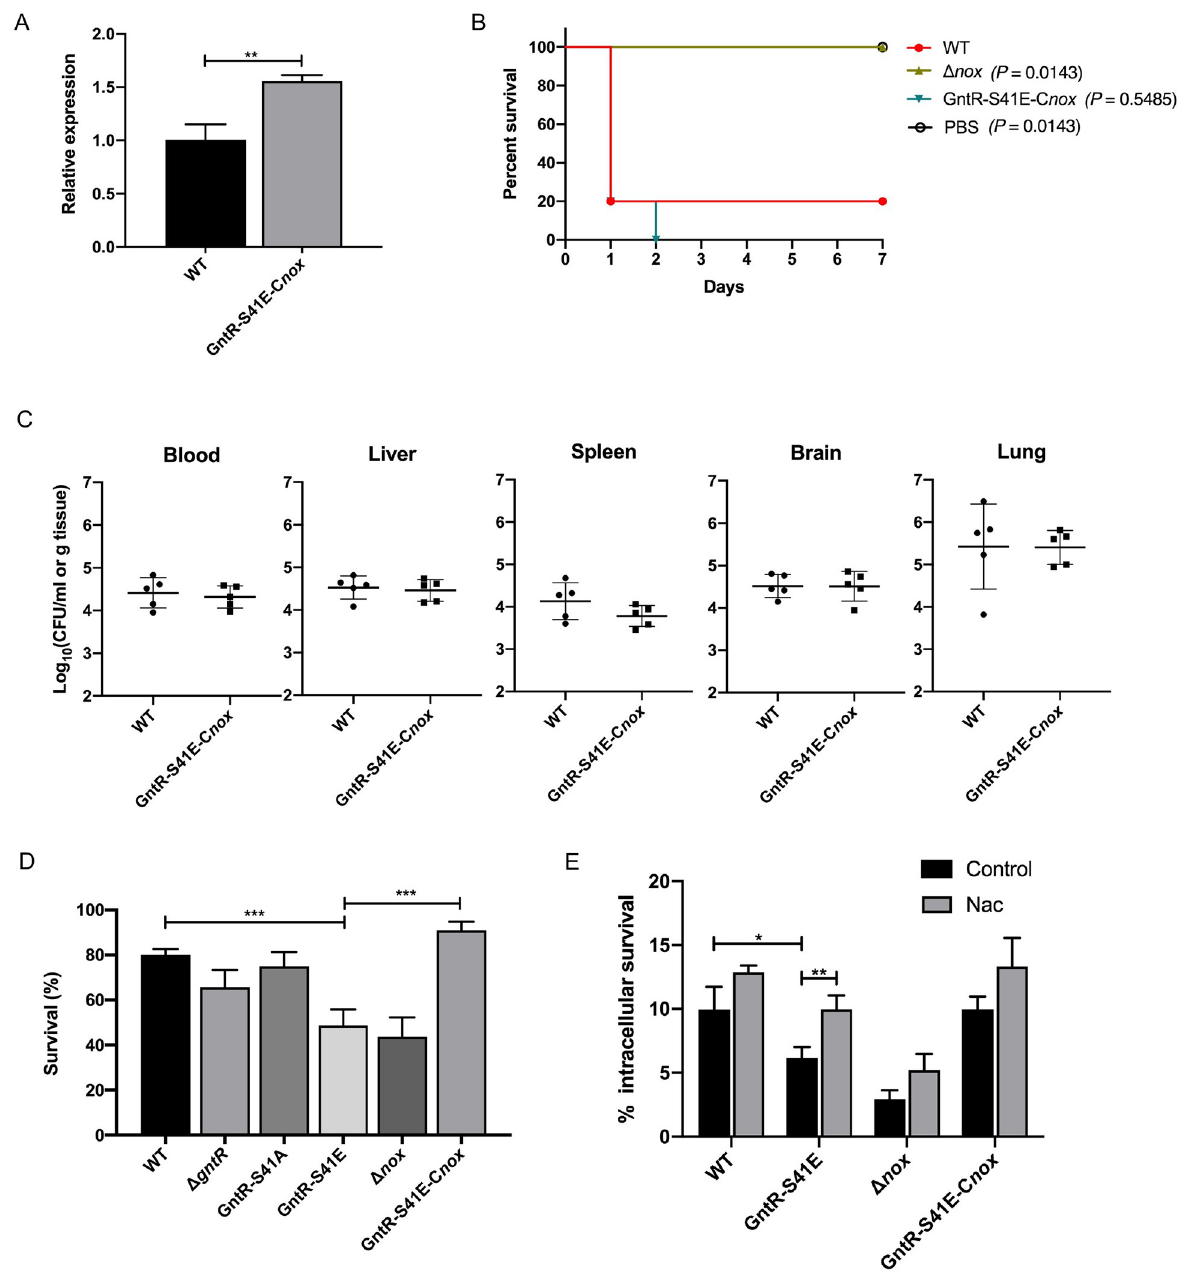
Fig 4. Attenuated virulence and antioxidative capacity of the phosphorylation of GntR are associated with the transcriptional repression of nox . (A) The gene of nox transcript levels in WT SS2 and GntR-S41E-C nox were detected by RT-qPCR. (B) BALB/c mice were challenged by intraperitoneal injection with WT SS2 and GntR-S41E-C nox at a dose of 5 × 10 8 CFUs/mice (n = 5 mice/group), and the survival time was monitored. (C) Bacterial loads in the blood, lung, liver, spleen, and brain of BALB/c mice were challenged with 5 × 10 7 CFUs WT SS2 and GntR-S41E-C nox by intraperitoneal injection at 24 hpi (n = 5 mice/group). (D) WT SS2, Δ gntR , GntR-S41A, GntR-S41E, Δ nox , and GntR-S41E-C nox were treated with 30 mM H 2 O 2 for 30 min, and the number of viable bacteria was subsequently determined by CFU counts. The bacterial survival is expressed as the percentage survival of the initial bacterial count at 0. (E) RAW264.7 cells were infected with 10 MOI WT SS2, GntR-S41E, Δ no x, and GntR-S41E-C nox for 1 h. After 1 h of antibiotic treatment, the amount of internalized bacteria was regarded as 100% to calculate percent survival. The cells were lysed to release bacteria after 3 h of antibiotic treatment and were serial-diluted in PBS buffer and spread onto THY plates, incubated at 37˚C for 16 h. Black bars correspond to the control group, and gray bars correspond to the NAC-treated group. The data shown represent three independent experiments and are presented as the mean ± standard deviations. Statistical analysis was performed using an unpaired t -test (A), Long-rank (B), one-way ANOVA (D) and two-way ANOVA (E). � , P < 0.05; �� , P < 0.01; ��� , P < 0.001.